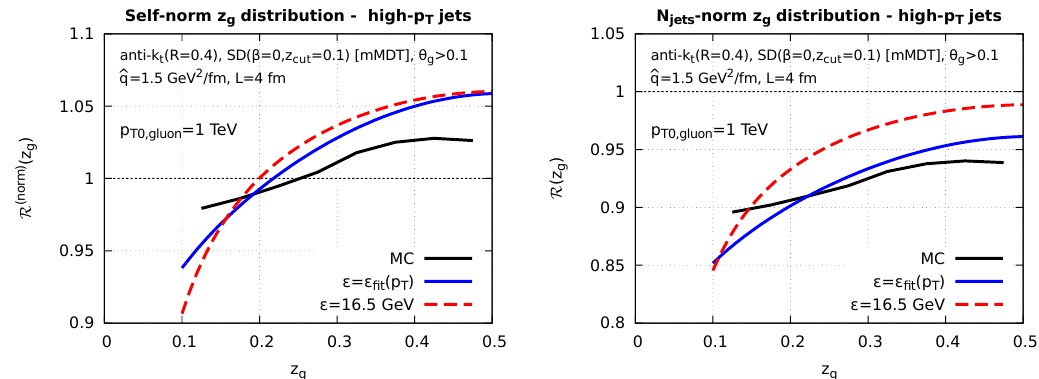
Figure 12 . Our MC results for the medium/vacuum ratio of the z g distributions associated with gluon-initiated jets with initial energy p T 0 = 1 GeV are compared to our analytic predictions for the two scenarios of energy loss described in the text. The left plot refers to the self-normalised distributions, cf. eq. (5.9), and the right plot to the N jets -normalised